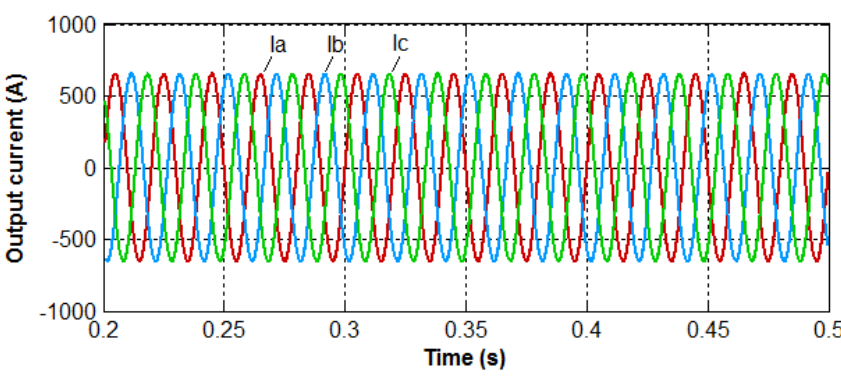
Figure 6. Output voltages of the grid-side converter with MMC.